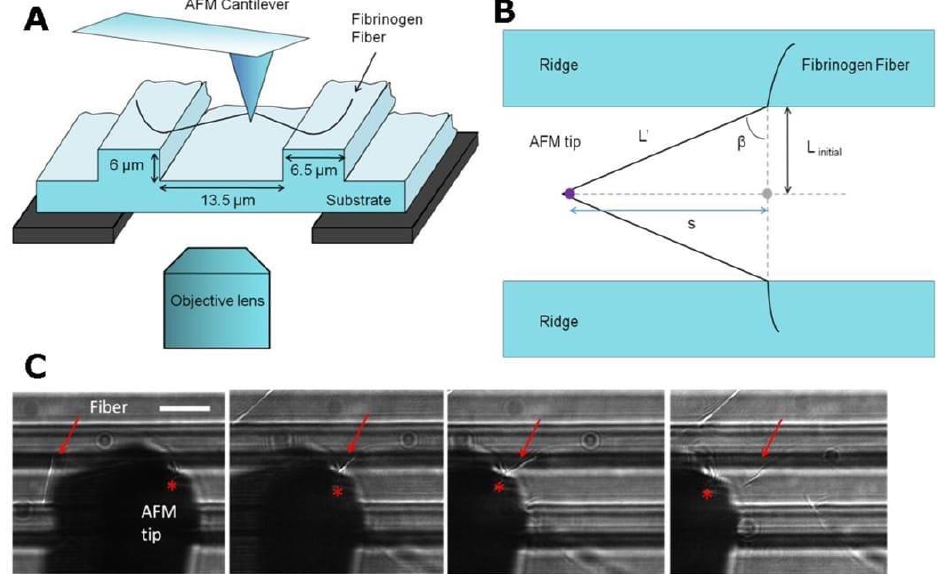
Figure 4. Individual fiber manipulation method: fibrinogen fiber manipulation scheme ( A ); top view scheme ( B ), where L initial and L ′ are the lengths of the initial and stretched fiber; optical microscopy visualization of manipulation ( C ) [77].